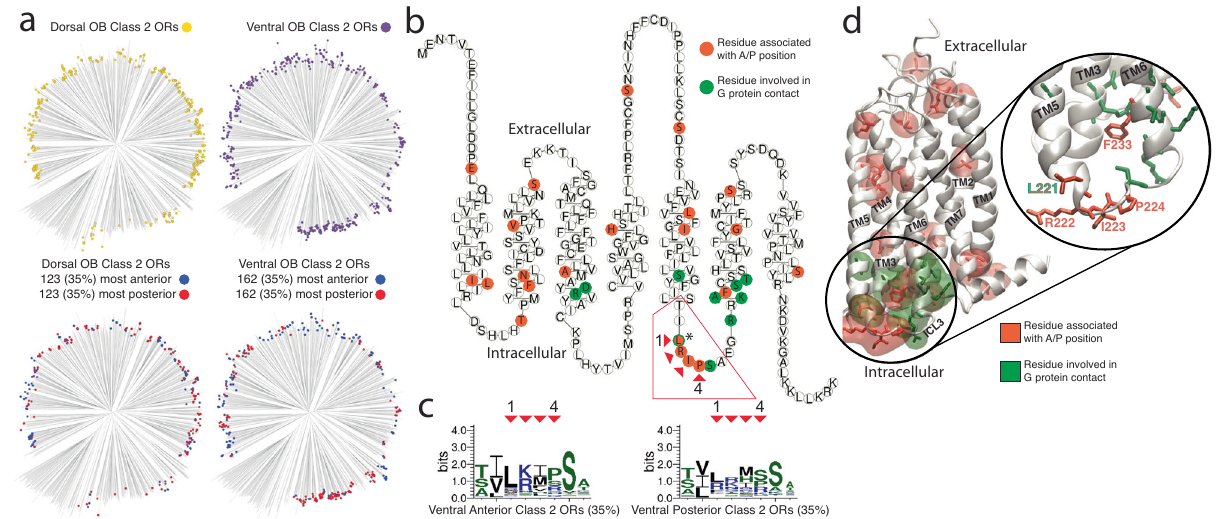
Fig. 5 | Amino acid residues associated with anterior and posterior targeting ORs. a Phylogenetic tree of all Class II dorsal OB OR proteins (top left, n =354), all Class II ventral OB ORs (top right, n =464), the most anterior (35%, blue) and most posterior (35%, red) Class II ORs from the dorsal (bottom left) and ventral OB (bottom right) DV zones. b Snakeplot of the Class II OR consensus protein sequence; orange residues have signi fi cantly different physicochemical prop- ertiesforventral,anterior,orposteriorClassIIORscomparedtoallventralClass II ORs. Green residues indicate residues known to be involved in Class A GPCR activation through contact with the G protein (* indicates the single residue which was identi fi ed as being both associated with G protein contact and identi fi ed as signi fi cantly different for ventral, anterior, Class II ORs). Source